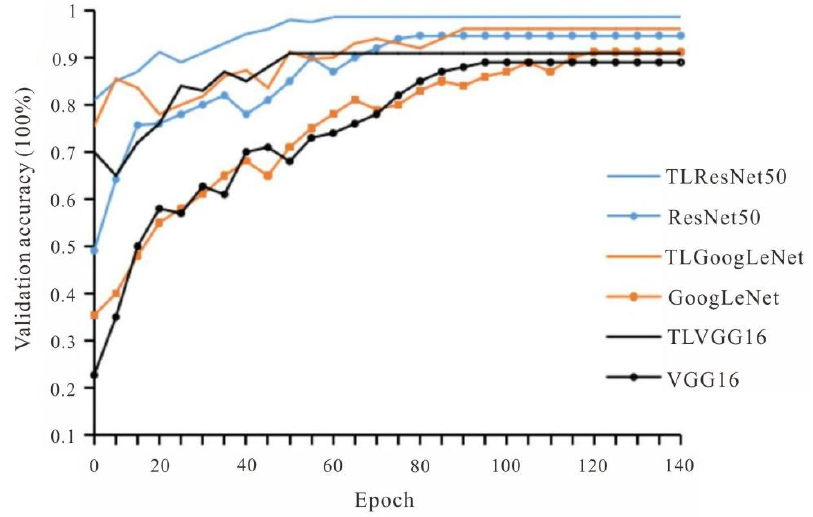
Figure 13. Training accuracy of several